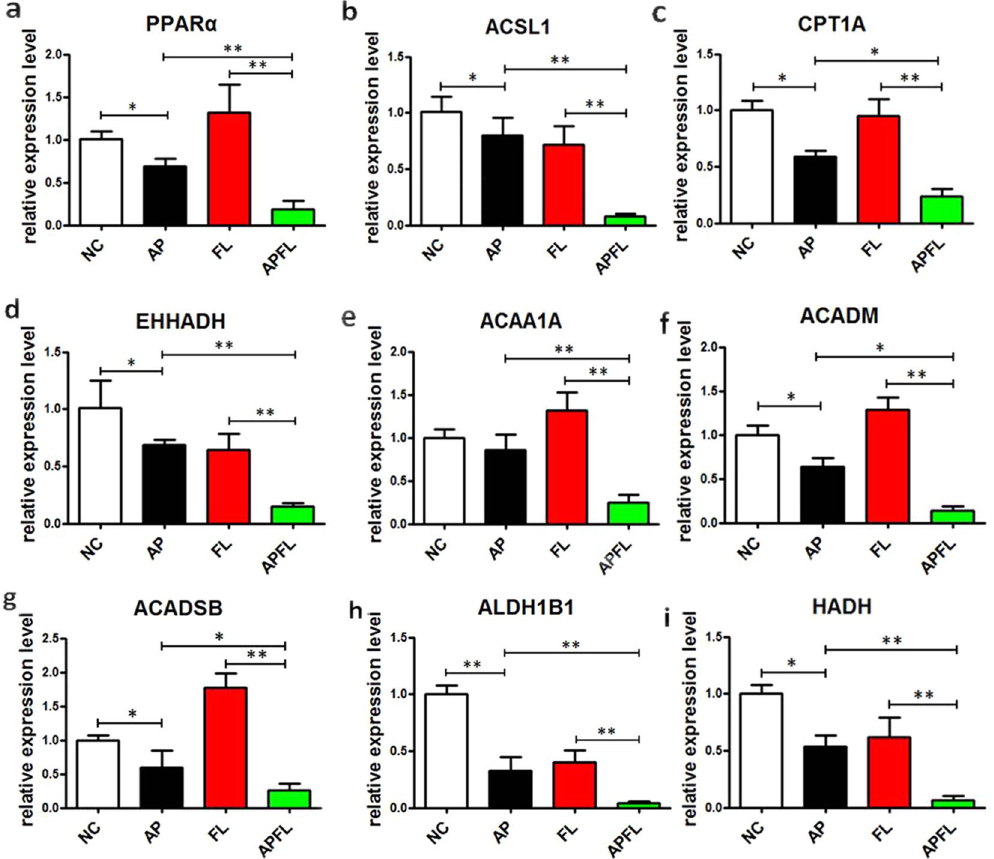
Figure 8. Quantitative RT-PCR validation of the selected dysregulated genes associated with fatty acid degradation. The expression levels of PPAR α ( a ), ACSL1 ( b ), CPT1A ( c ), EHHADH ( d ), ACAA1A ( e ), ACADM ( f ), ACADSB ( g ), ALDH1B1 ( h ) and HADH ( i ) in NC, AP, FL and APFL were validated using qRT-PCR. The bar graph shows the expression of each gene in AP, FL, APFL relative to the average expression levels in NC. All error bars indicated S.D. * P < 0.05 vs NC, ** P < 0.01 vs NC, # P < 0.05 vs FL.